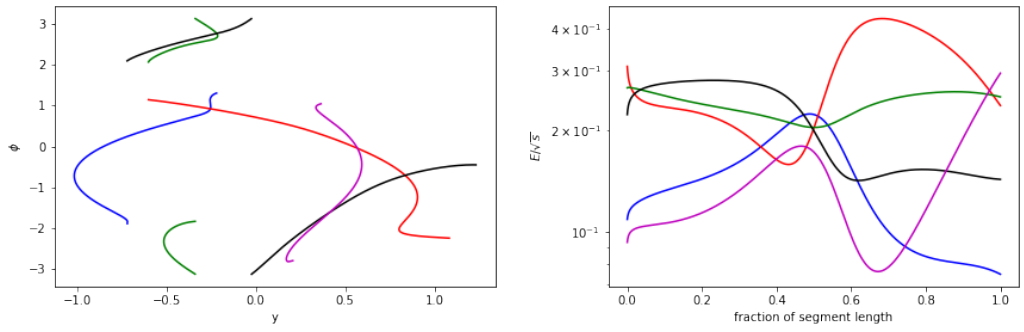
Figure 8 . Left: rapidity and azimuthal angle trajectories for the five final state particles in the trajectories used in section 3.3. Right: Evolution of the same particle energies as a function of the position along the segment between the two random points in the unit